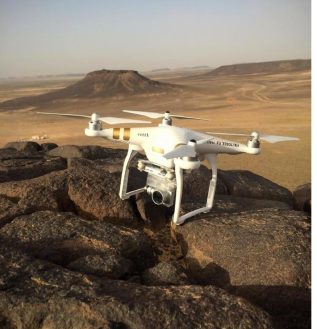
Figure 5. Phantom 3 at Wadi al-Qattafi, looking south with Mesa 3 in the background.